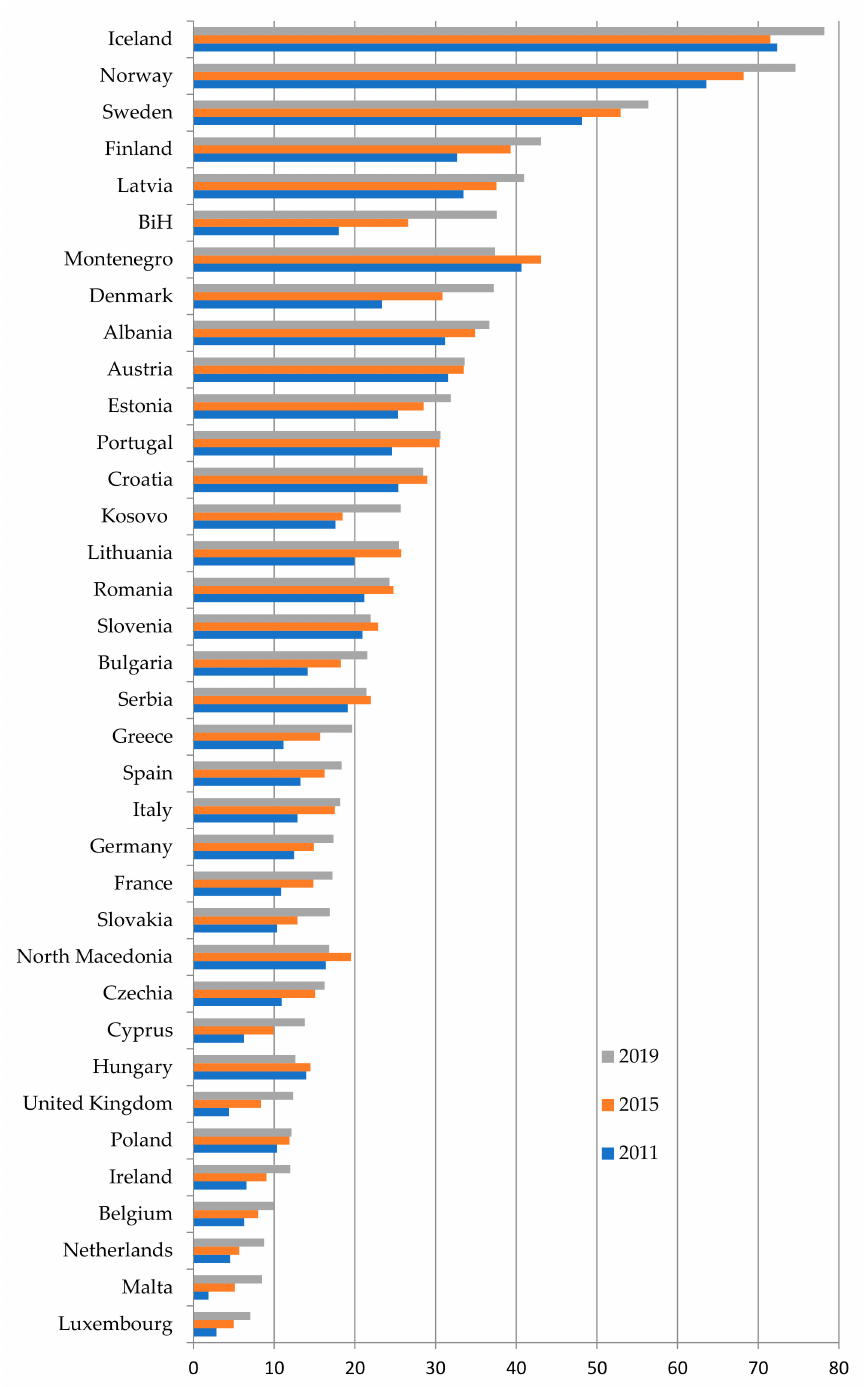
Figure 7. Share of renewable energy in final gross energy consumption in European countries in 2011, 2015, 2019 (in %). Source: own preparation based on Eurostat database